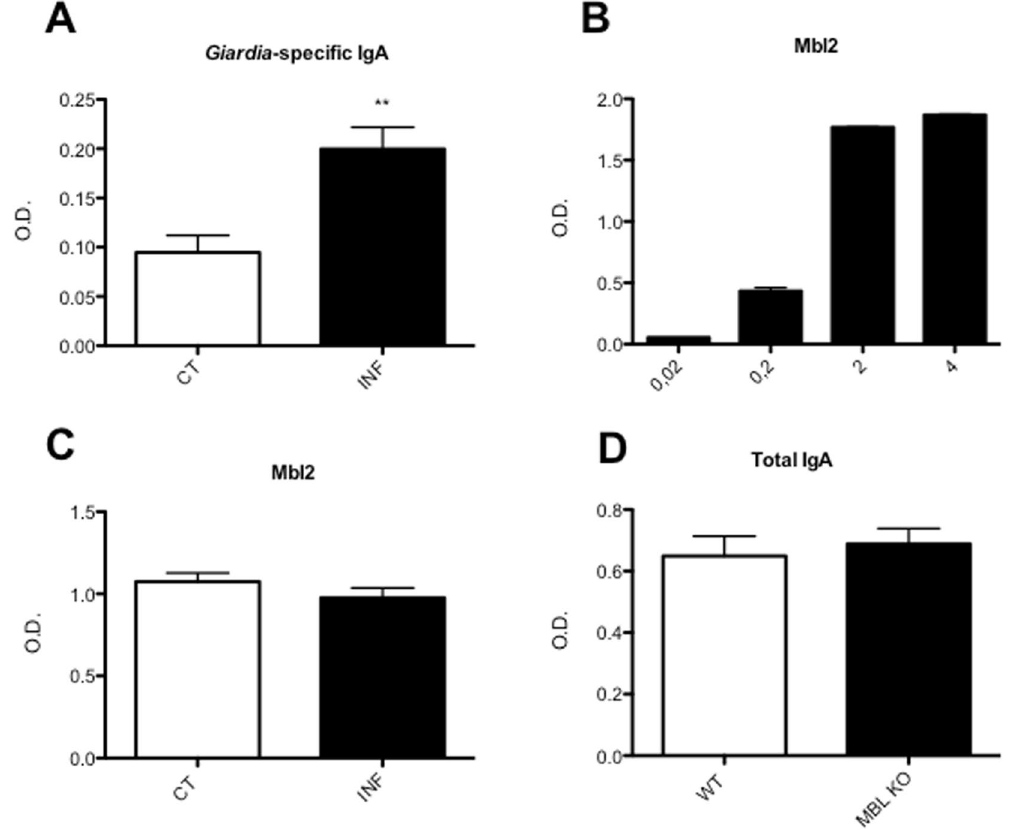
Figure 7. Fecal total IgA levels, Giardia -specific IgA levels, and Mbl2 levels, as measured by ELISA. ( A ) Giardia -specific IgA levels were measured in fecal samples from C57BL/6 WT uninfected control and G . muris infected mice. Optical density is shown. ( ** p < 0.01). ( B ) ELISA plates coated with trophozoites were incubated with recombinant Mbl2 in different concentrations (0.02–4 μ g/mL). The amount of bound Mbl2 was measured through optical density. ( C ) ELISA plates coated with trophozoites were incubated with fecal samples from either C57BL/6 WT uninfected control mice or WT G . muris infected mice. Recombinant Mbl2 (2 μ g/mL) was added and the amount of bound Mbl2 was measured. ( D ) Total fecal IgA levels were measured in C57BL/6 uninfected WT mice and Mbl KO uninfected